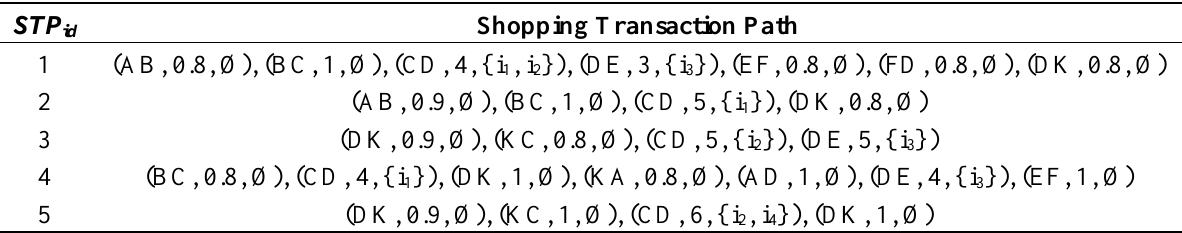
Figure 1. The framework for RFID based shopping transaction path mining. Table 2 . An example of shopping transaction path